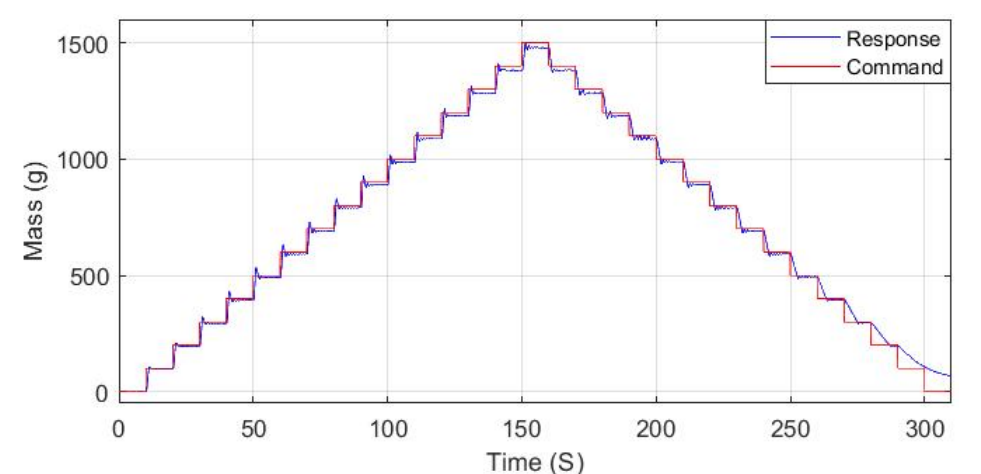
Figure 11. Closed-loop force control of a stair command signal.